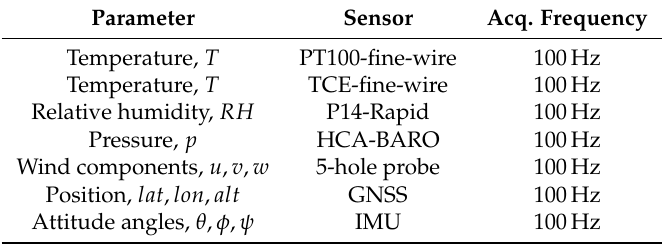
Table 4. Specifications for the Multi-purpose Airborne Sensor Carrier (MASC-2) UAV.